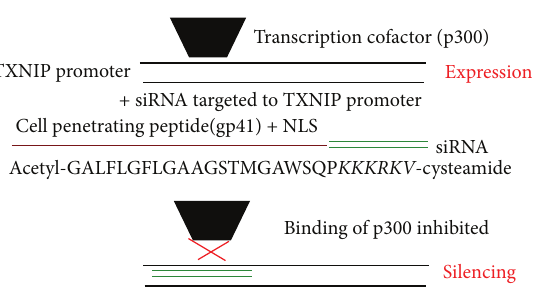
Figure 5: TXNIP: a novel therapeutic target and a novel thera- peutic strategy. Hyperglycemia induces TXNIP expression, which leads to oxidative damage that is the major downstream effect of hyperglycemia. Indeed, we demonstrated that TXNIP is responsible for neurovascular dysfunction in DR. We developed a novel gene therapy technique: we injected in the diabetic retina small interfer- ing RNA (siRNA) targeted to TXNIP promoter associated with cell penetrating peptides (CPP) containing a nuclear localization signal. In diabetic conditions, the cotranscriptional factor p300 is associ- ated with TXNIP promoter, leading to enhanced TXNIP expression. When we injected the siRNA targeted to TXNIP promoter, they completely block the recruitment of p300 on TXNIP promoter, inhibiting TXNIP expression. With this technique, we completely blocked the progression of